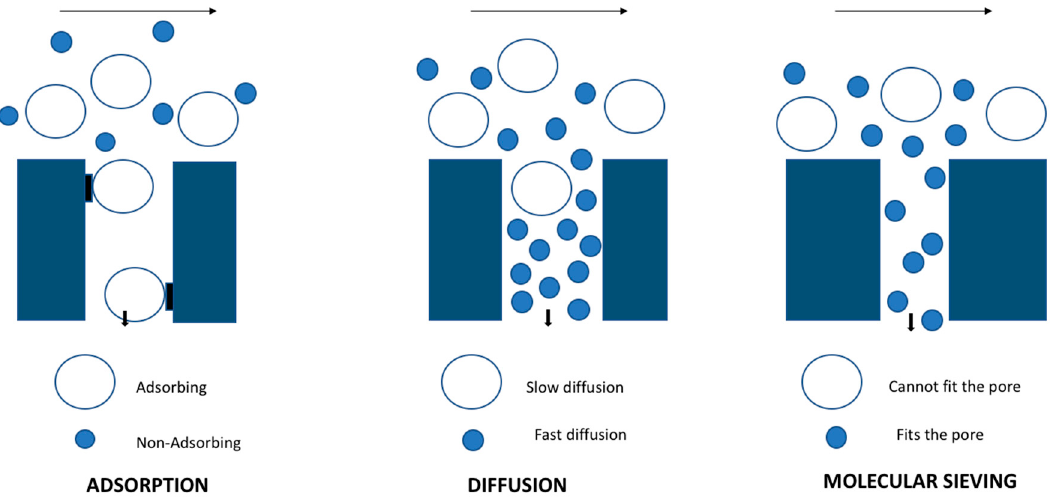
Figure 1. Separation mechanism in zeolite membrane.